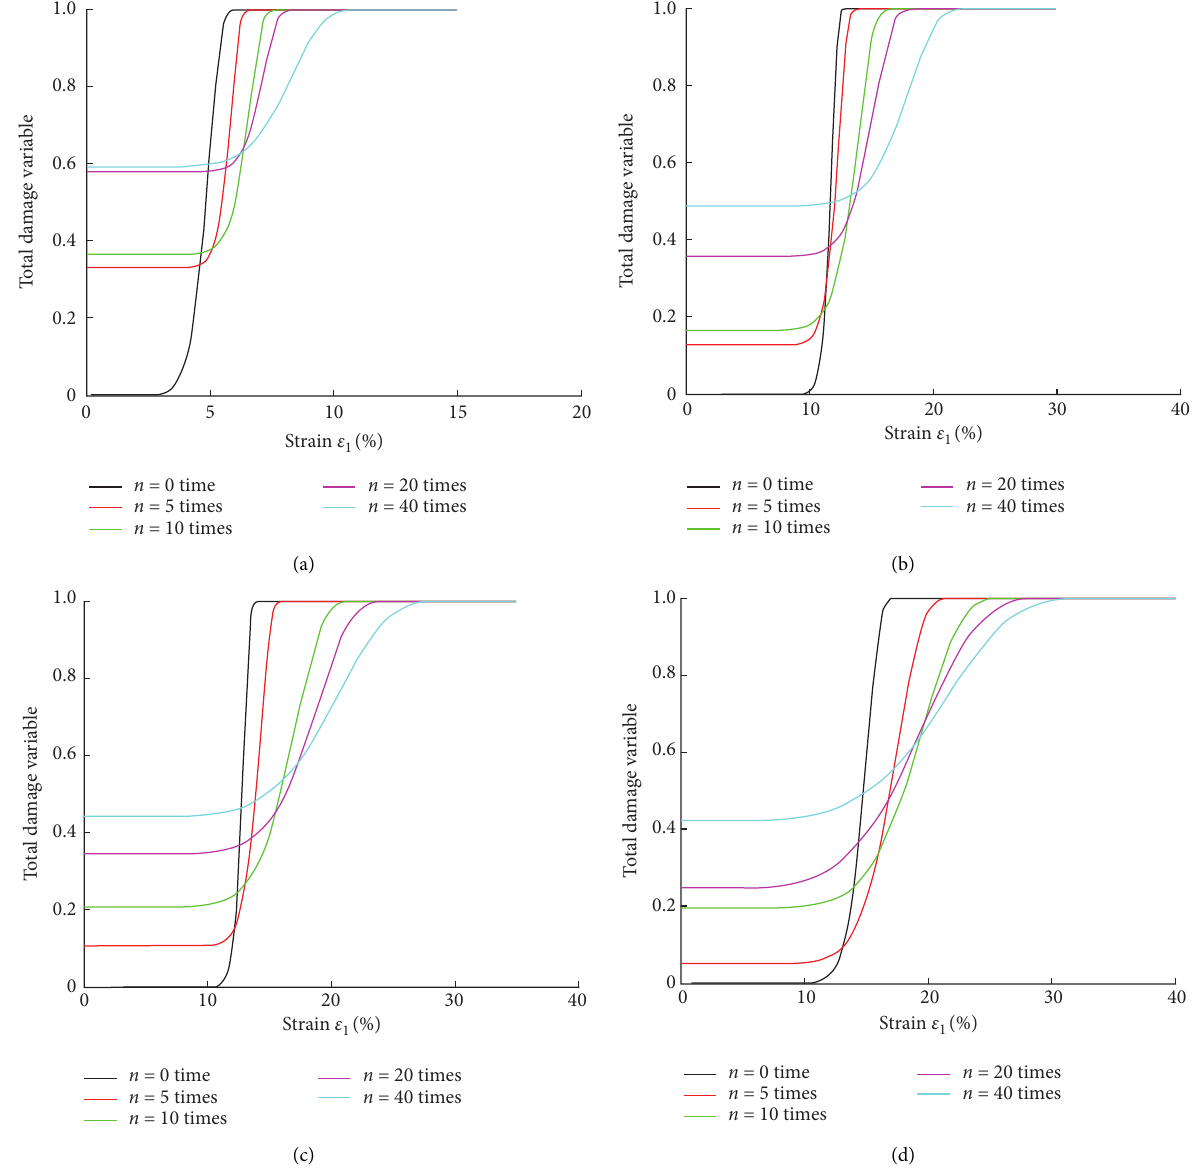
Figure 5: Total damage evolved curves on different confining pressures and freeze-thaw cycles of red sandstone. (a) σ (b) σ 3 � 2 MPa. (c) σ 3 � 4MPa. (d) σ 3 �